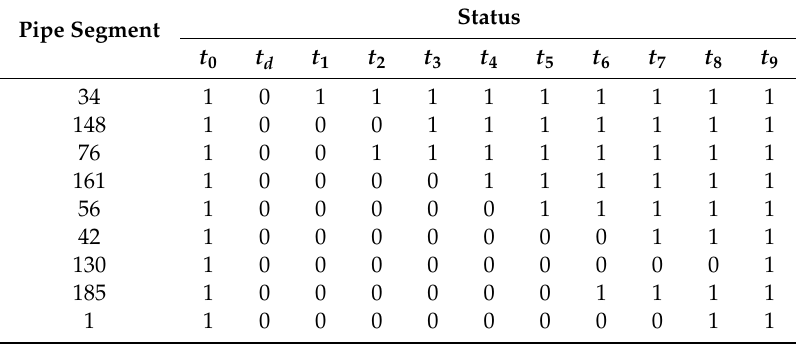
Table 9. LWDN behavior following restoration strategy